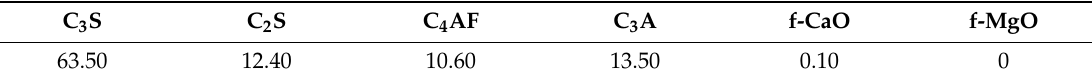
Figure 2. The XRD pattern of the homemade cement clinker. Table 4. The mineral contents of cement clinker without alkali